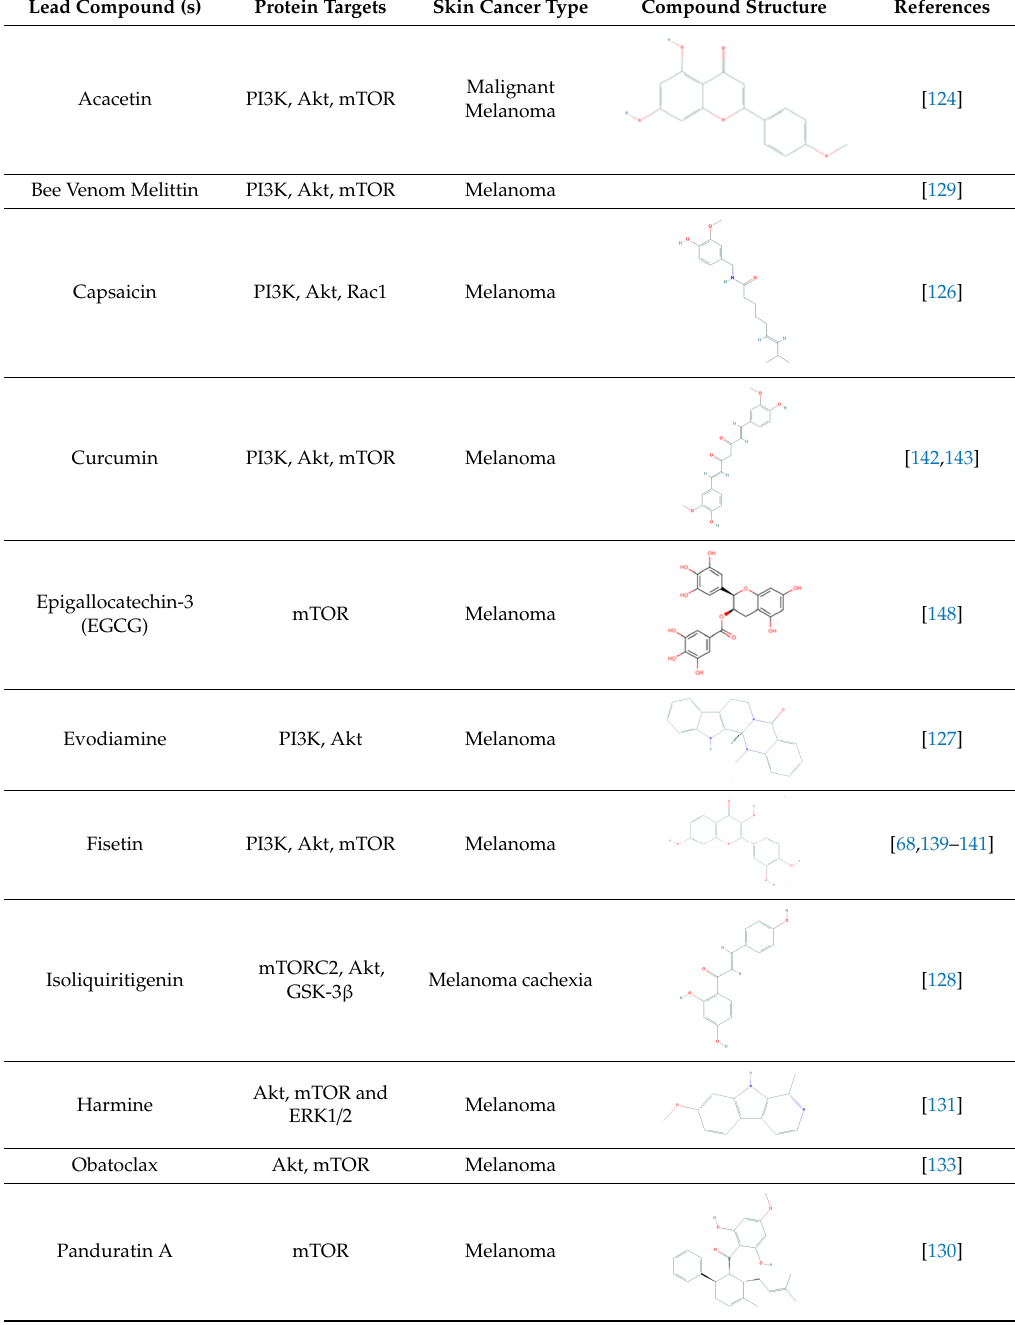
Table 2. List of reported lead natural dietary compounds and extracts targeting mTOR, PI3K, and Akt signaling pathway in various skin cancers. signaling pathway in various skin